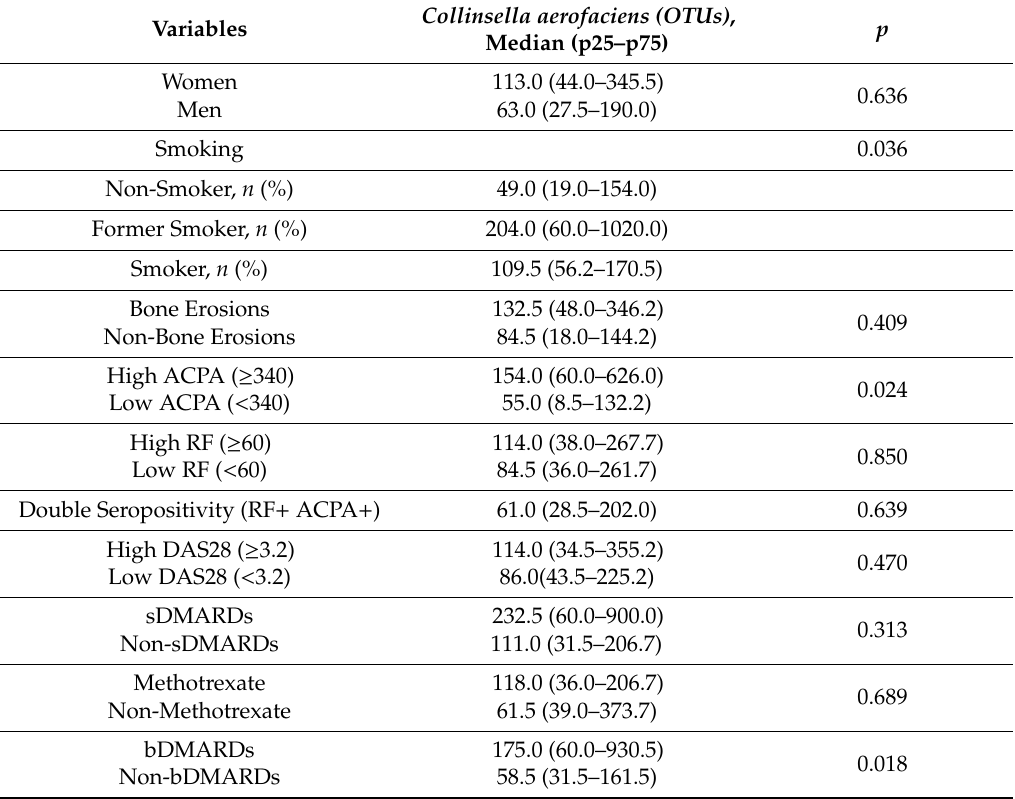
Table 2. Demographic and clinical characteristics of patients with RA harboring Collinsella aerofaciens